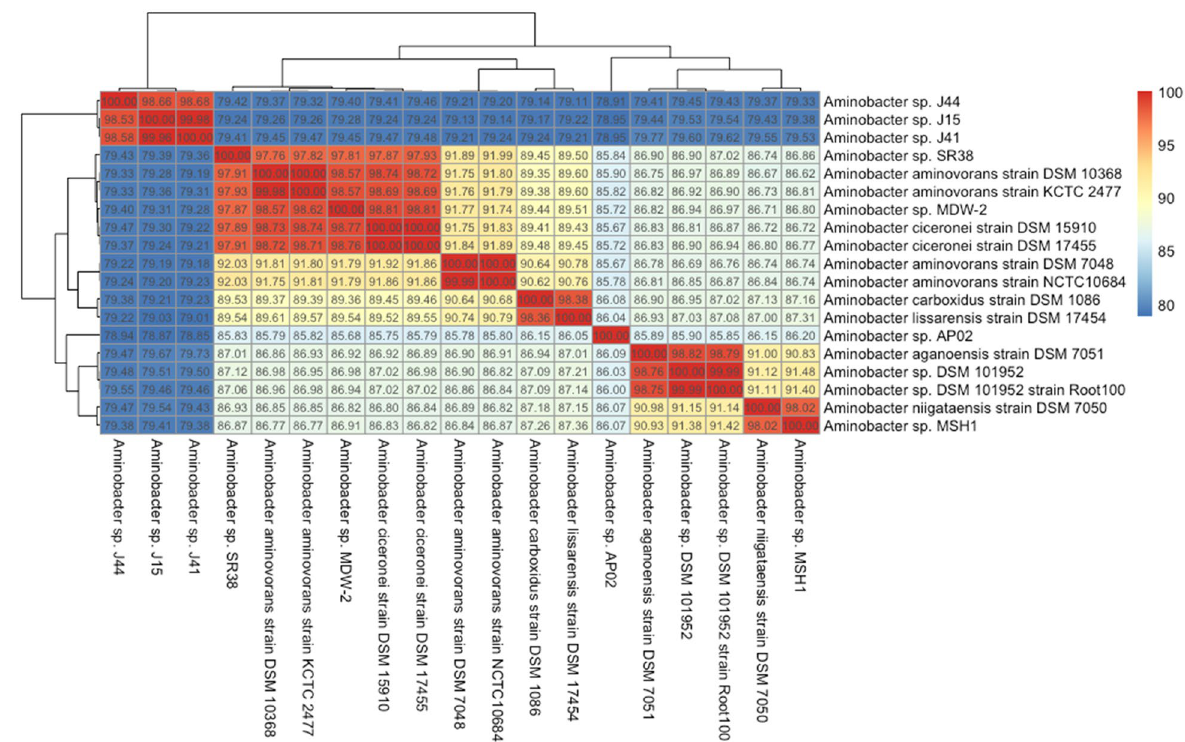
Figure 4. Heatmap of ANI values for all available Aminobacter genomes from NCBI (downloaded January 31, 2021). Genomes are clustered using hierarchical clustering of ANI values, as implemented in the R 59 package “pheatmap” 35 (v1.0.12).